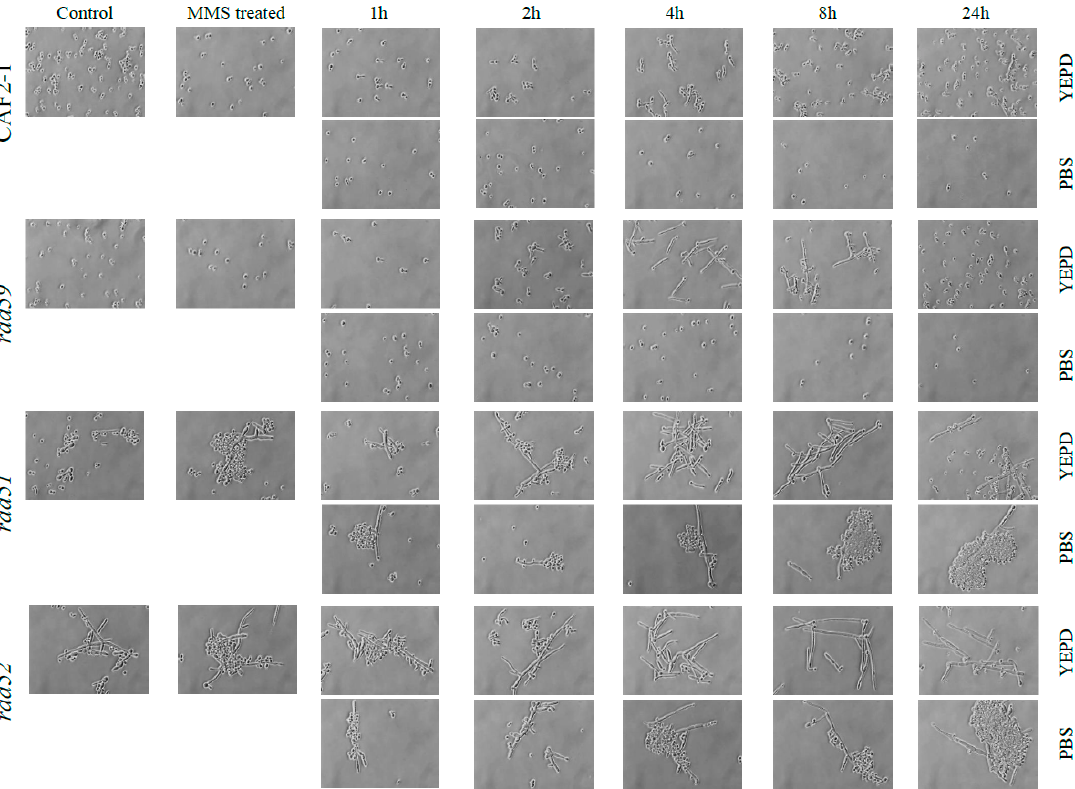
Figure 4. Cell morphology of MMS-treated exponentially growing cells from wild type and the indicated HR mutants during recovery in MMS-free YPD medium or PBS. For experimental conditions, see legend of Figure 3.